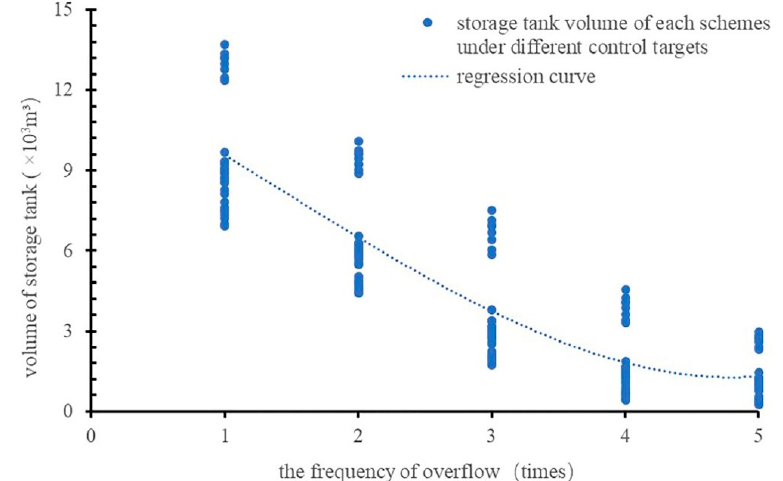
Figure 6. Change regulation of storage tank volumes.